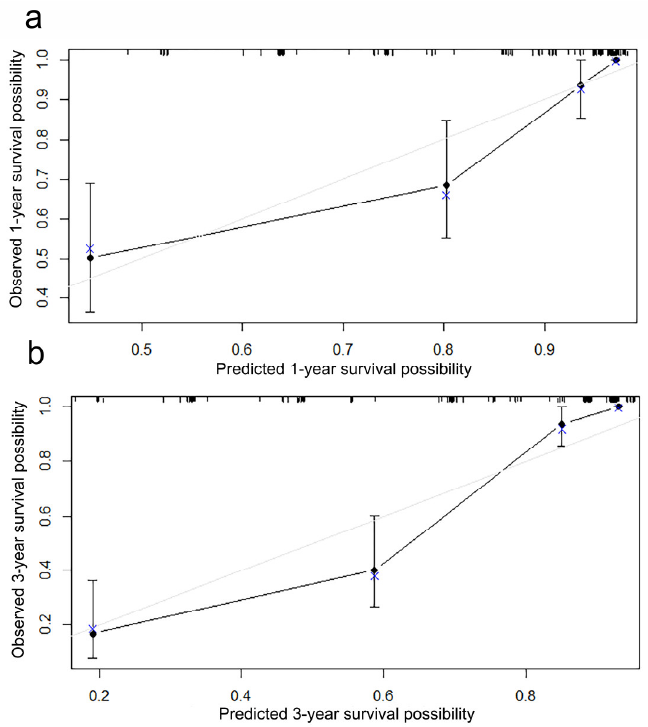
Figure 5. The 1000 bootstrap resampling internal verification correction for the nomogram of ( a ) 1- year disease-specific survival, ( b ) 3-year disease-specific survival in primary bile duct and ampullary neuro-endocrine neoplasms patients.